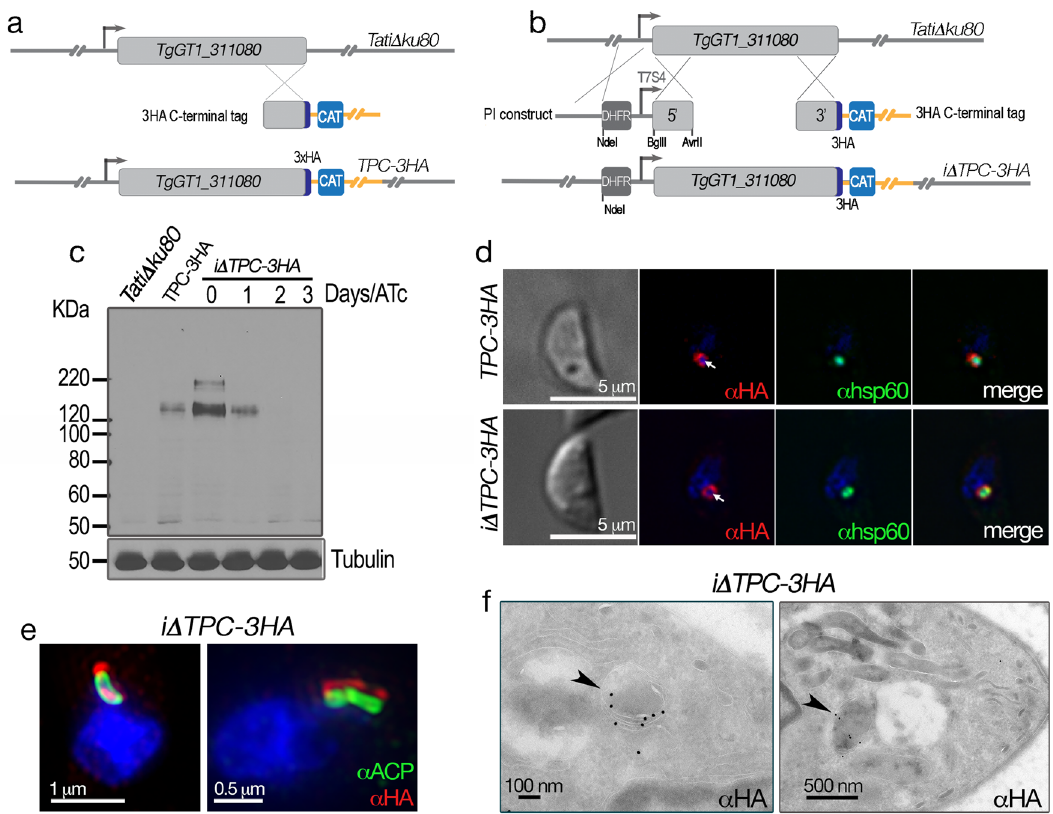
Fig. 2 The Toxoplasma TPC localizes to the apicoplast. a Cartoon showing in situ 3 ′ tagging of the TgTPC gene. b Diagram showing the genetic modi fi cations of the TgTPC gene by insertion of a regulatable promoter at the 5 ′ end of its coding sequence and the addition of the 3xHA at the 3 ′ end. DHFR, dihydrofolate reductase gene for pyrimethamine selection. CAT, chloramphenicol acetyl transferase for chloramphenicol selection. c Western blot analysis with α HA antibody (Rat antibody at 1:200) showing that ATc downregulates the expression of TgTPC to undetectable levels at 2 days. α Tubulin antibody (1:5,000) was used to control loading. N = 3. d IFAs of cells expressing TgTPC-3HA . α HA was used at 1:25 dilution ( red signal). The apicoplast marker was Hsp60 and the antibody α hsp60 was used at 1:1,000. The HA signal co-localizes with the apicoplast marker as well as the DAPI signal characteristic of the apicoplast. The white arrow points to the DAPI signal from the apicoplast DNA which is surrounded by the red signal. N = 3. e IFAs of the i Δ TPC-3HA mutant showing co-localization of the HA with the apicoplast marker. These images were obtained with a super-resolution microscope. The antibody used was α HA at a 1:25 ( red signal). The apicoplast marker was ACP and the α ACP antibody was used at a 1:200 dilution ( green signal). N = 2. f Immunoelectron microscopy with a α HA antibody showing TgTPC localization at the apicoplast identi fi ed by the characteristic 4 membranes (arrowheads). N =